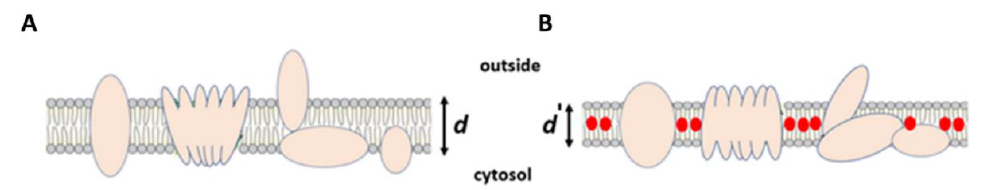
Figure 4. Plasma/cell membrane electrical capacitance is a biophysical parameter, which is related to the compositional and functional organization of the lipid bilayer. Drug partitioning in the lipid bilayer changes the properties of the cell membrane and alters membrane thickness. Changes in the membrane capacitance [( A ) before applying the drug; red circles], corelates with drug partitioning [( B ) drug – membrane interaction] in the lipid membrane and alters membrane thickness.